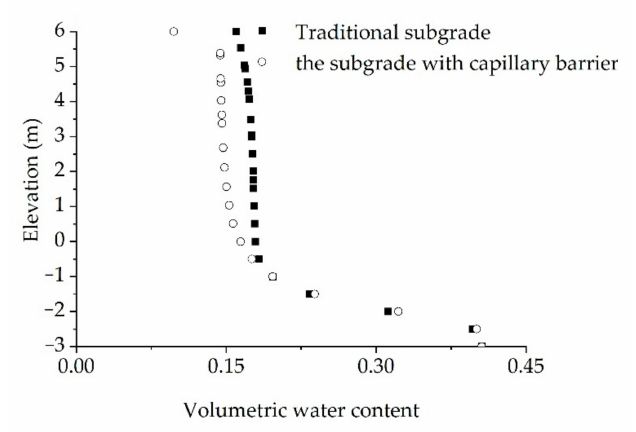
Figure 7. Volumetric water content profiles at section